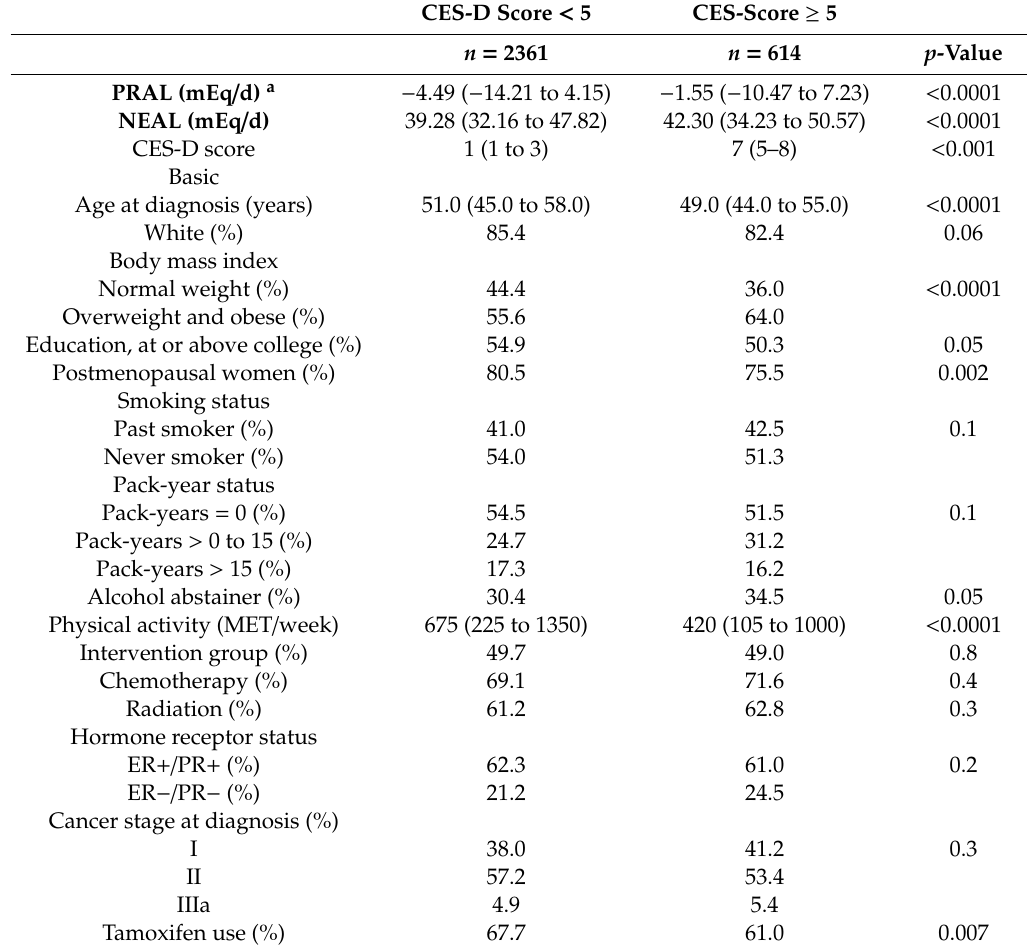
Table 1. Baseline characteristics of breast cancer survivors by depression symptoms. CES-D scores ≥ 5 indicate depressive